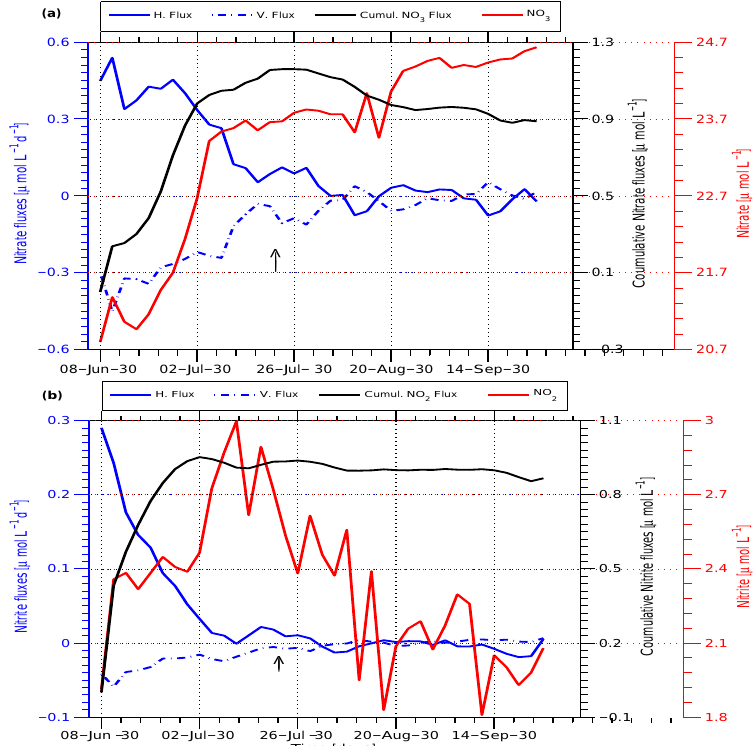
Figure 10. Nitrate (a) and nitrite (b) advective fluxes divergence into the eddy A sim . Lines indicate horizontal (solid blue, µmolL − 1 d − 1 ), vertical (dashed blue, µmolL − 1 d − 1 ) and cumulative (black, µmolL − 1 ) advective fluxes divergence. Red line represents the available ni- trate (a) and nitrite (b) within the eddy (µmolL − 1 ). Arrows indicate the time when the sections in Fig. 4 were